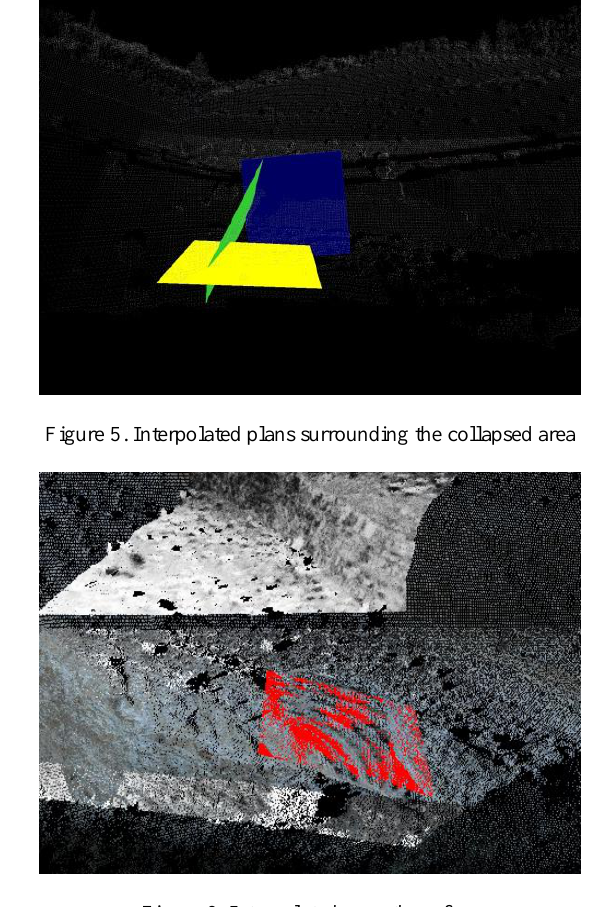
Figure 6. Interpolated smooth